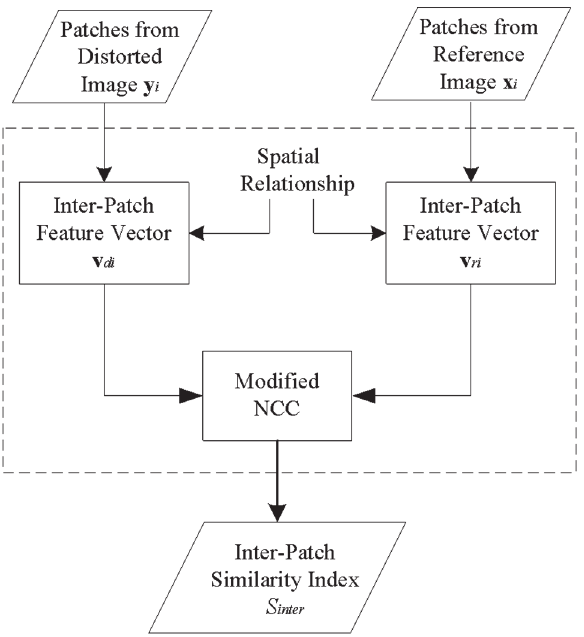
Fig 3. Flowchart of measuring the inter-patch similarity. The dashed block in Fig. 3 replaces block “ inter- patch similarity ” in Fig. 1.